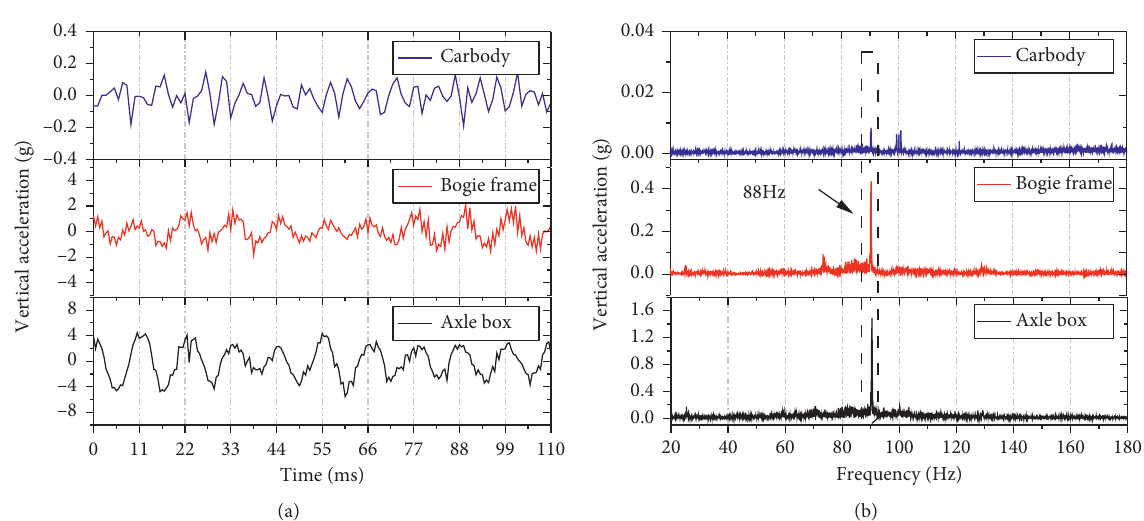
Figure 8: Sleeper passing impacts in test measurements: (a) time history of vertical accelerations of the vehicle components; (b) vertical accelerations in frequency domain.